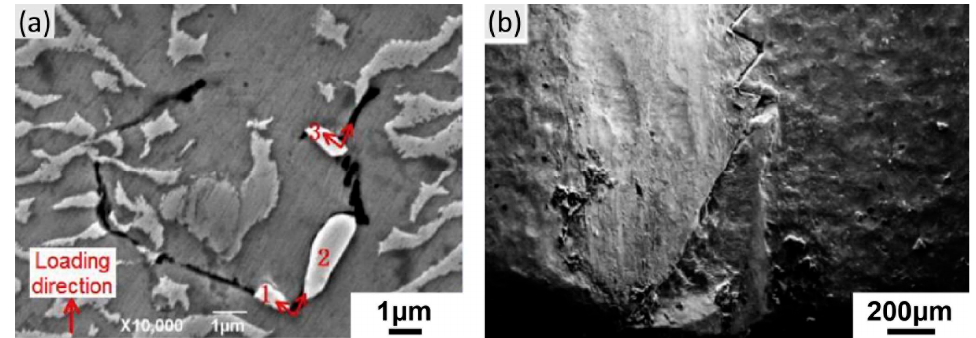
Figure 22. ( a ) The microcrack initiation and propagation near the TCP phase of DD6 alloy after creep at 1100 °C/140 MPa (Numbers 1,2 and 3 mark the TCP phases.) and ( b ) the fracture crack in the tenon of an aero-engine single crystal turbine blade [64].